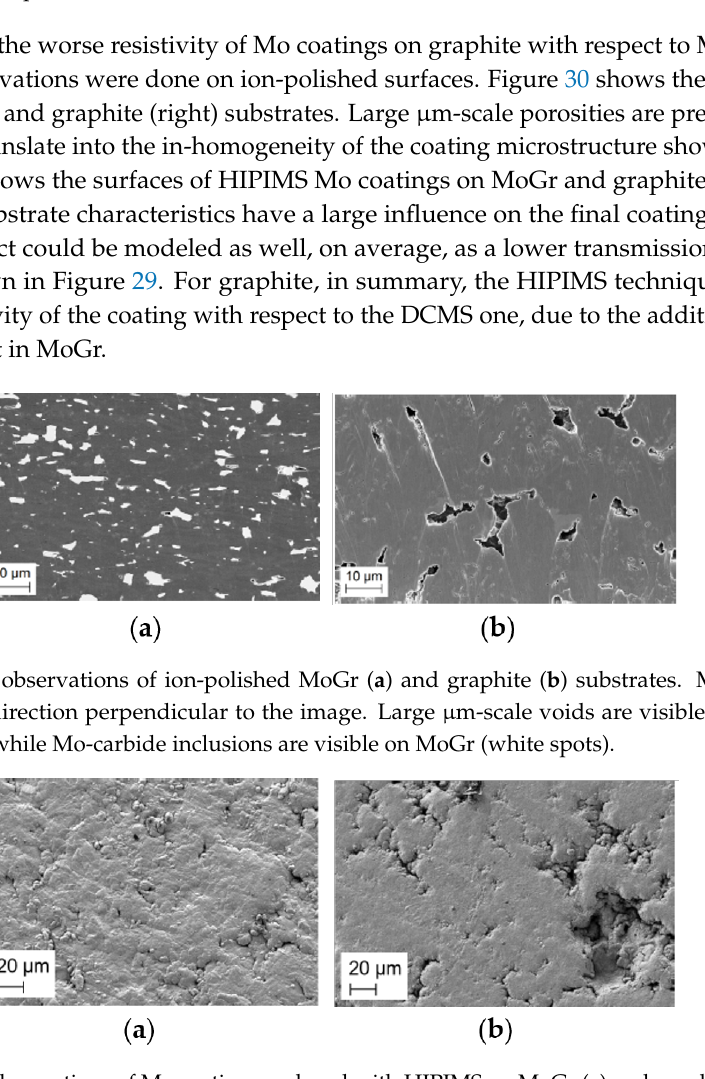
Figure 29. Relative change in resistivity with respect to the ratio of grain size D and mean free path λ ∞ for Mo coating layers. Full lines correspond to different transmission T between grain boundaries. Dashed lines correspond to the mean RF values of Table 7.